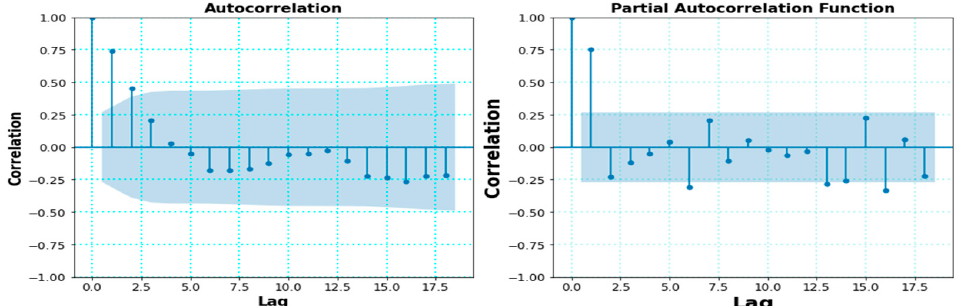
Figure 13. The weekly time series ACF and PACF plot at no transformation.